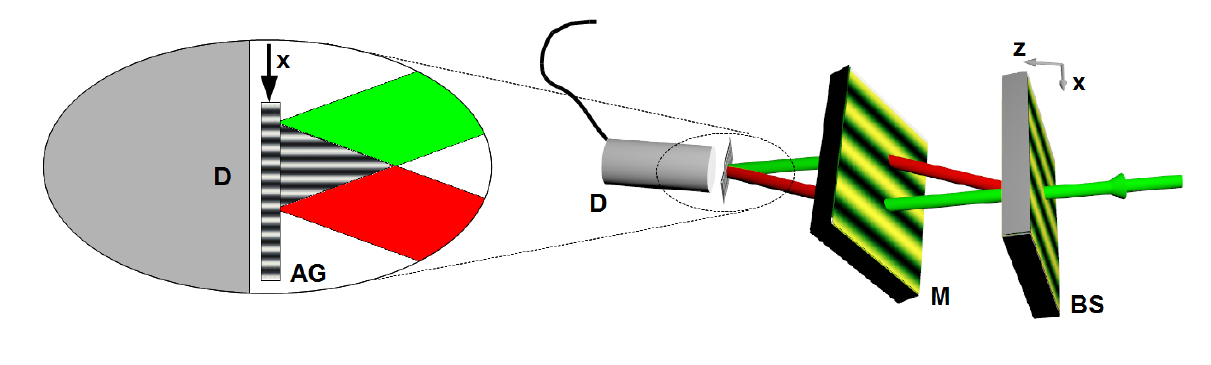
Figure 17. VCN Mach-Zehnder interferometer with the third grating replaced by an absorption grating (AG). The x position of the grating is scanned to measure the intensity modulation formed by the superposed beams with the detector